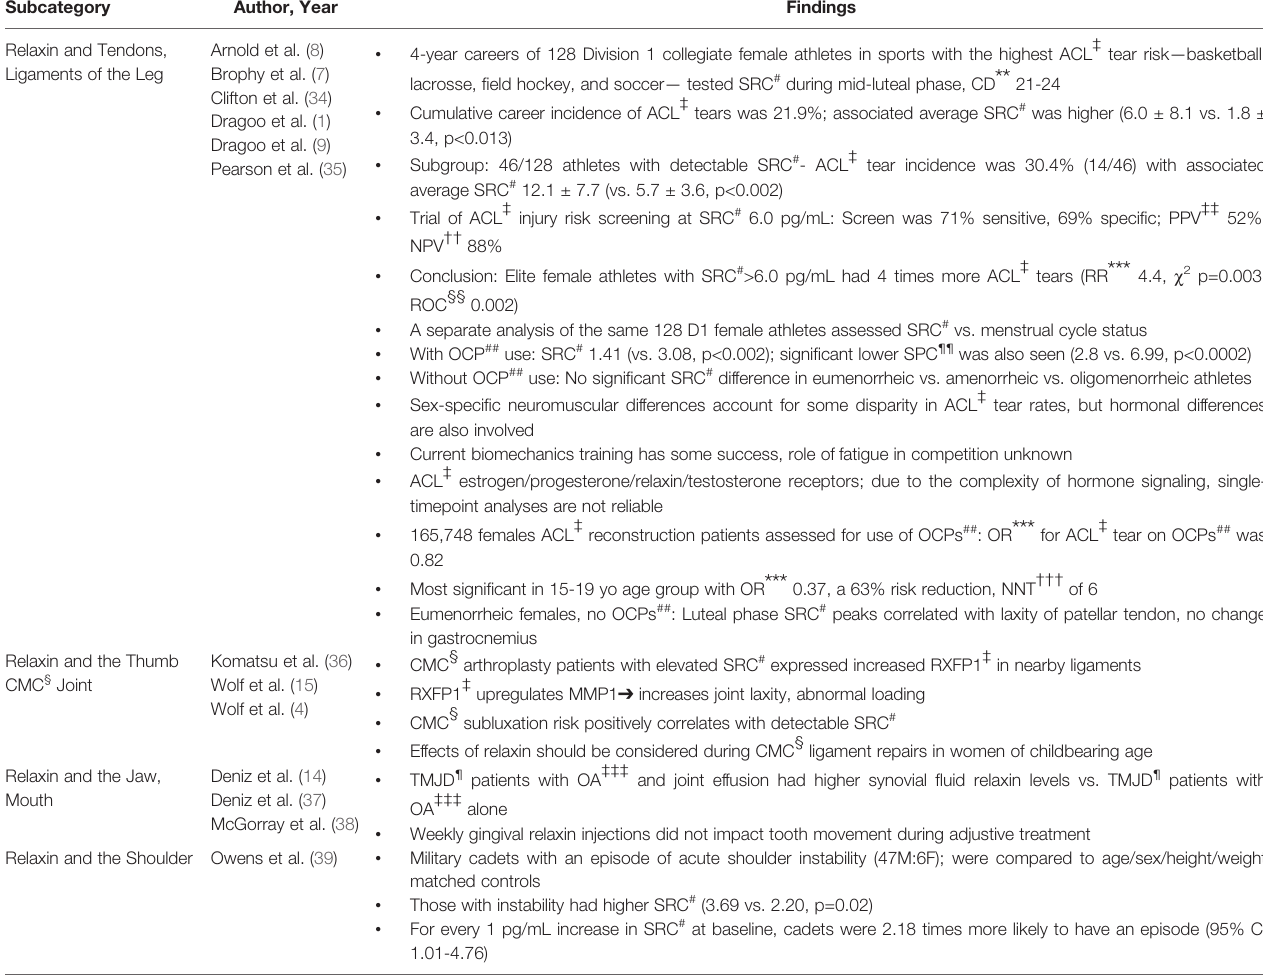
TABLE 3 | Musculoskeletal effects of relaxin- relevant literature fi ndings. Subcategory Author, Year Findings Relaxin and Tendons, Arnold et al. (8) Brophy et al. (7) Ligaments of the Leg Clifton et al.